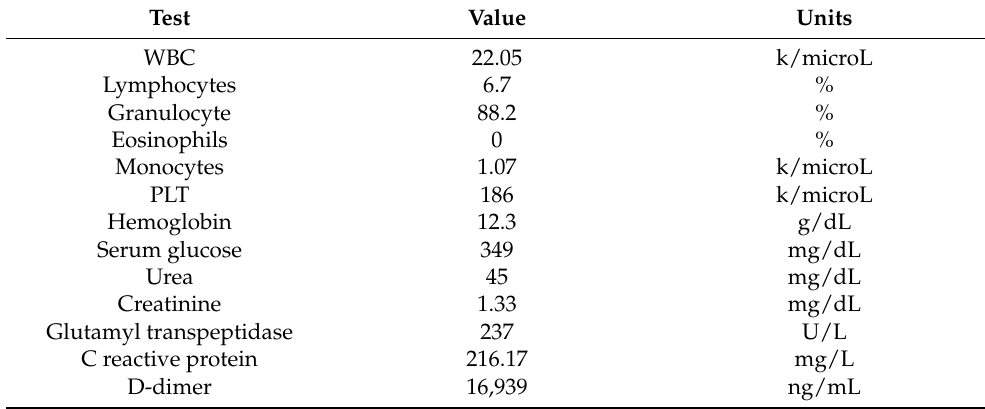
Table 1. Lab tests of the patient at admission. Only modified values have been recorded here. Test Value Units WBC 22.05 k/microL Lymphocytes 6.7 % Granulocyte 88.2 % 0 % Monocytes 1.07 k/microL k/microL